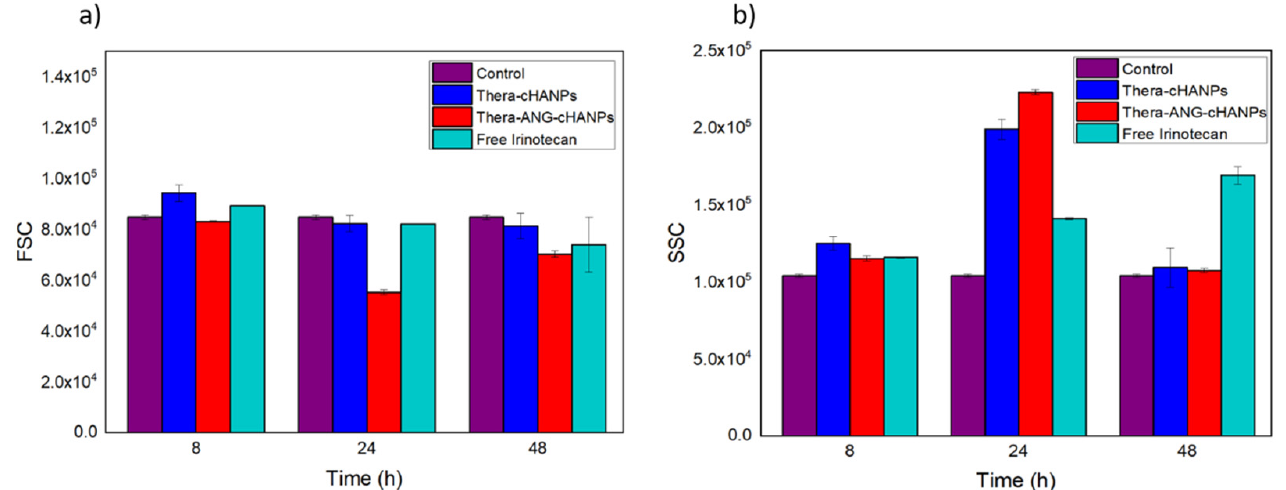
Figure 8. Quantitative uptake of NPs by U87-MG cells by flow cytometry. ( a ) Forward scattering (FSC) of U87 after incubation with theranostic Thera-cHANPs and Thera-ANG-cHANPs ( b ) Side scattering (SSC) of U87 after incubation with Thera-cHANPs and Thera ANG-cHANPs.